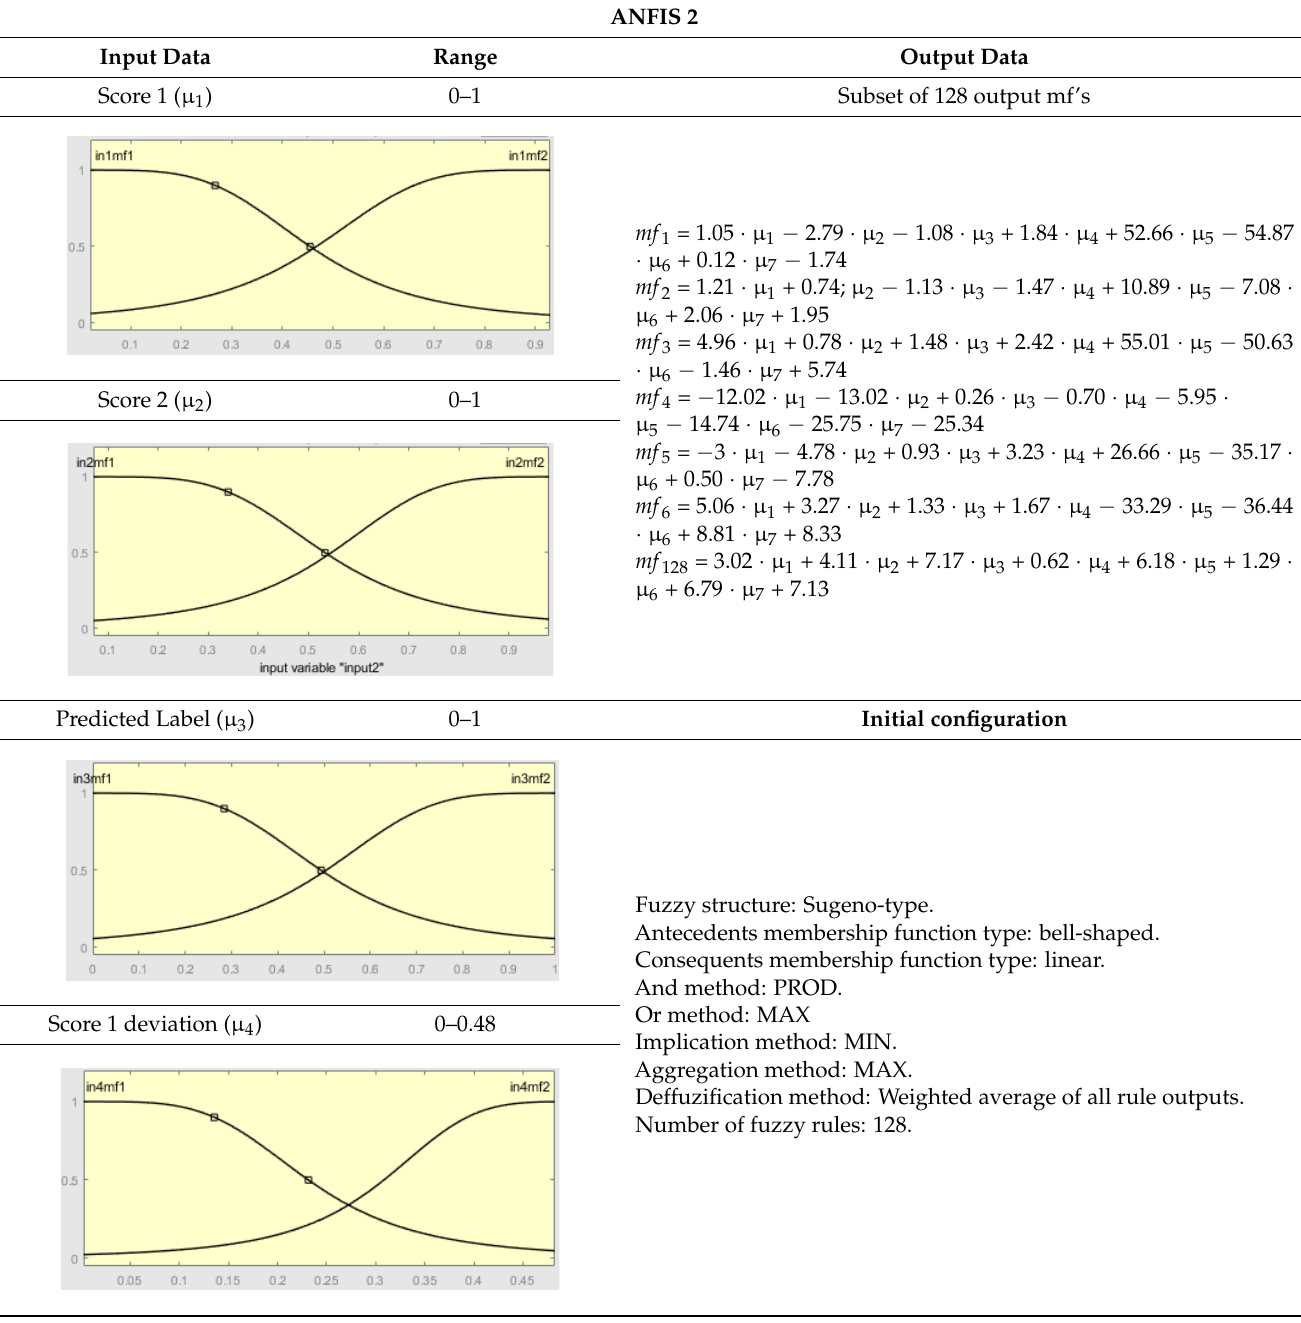
Table 8. Implementation of the second ANFIS for AHI =